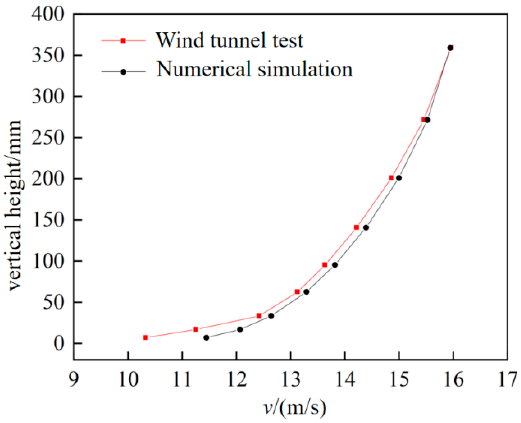
Figure 2. Comparison of wind-speed profiles between wind-tunnel test and numerical simulation.